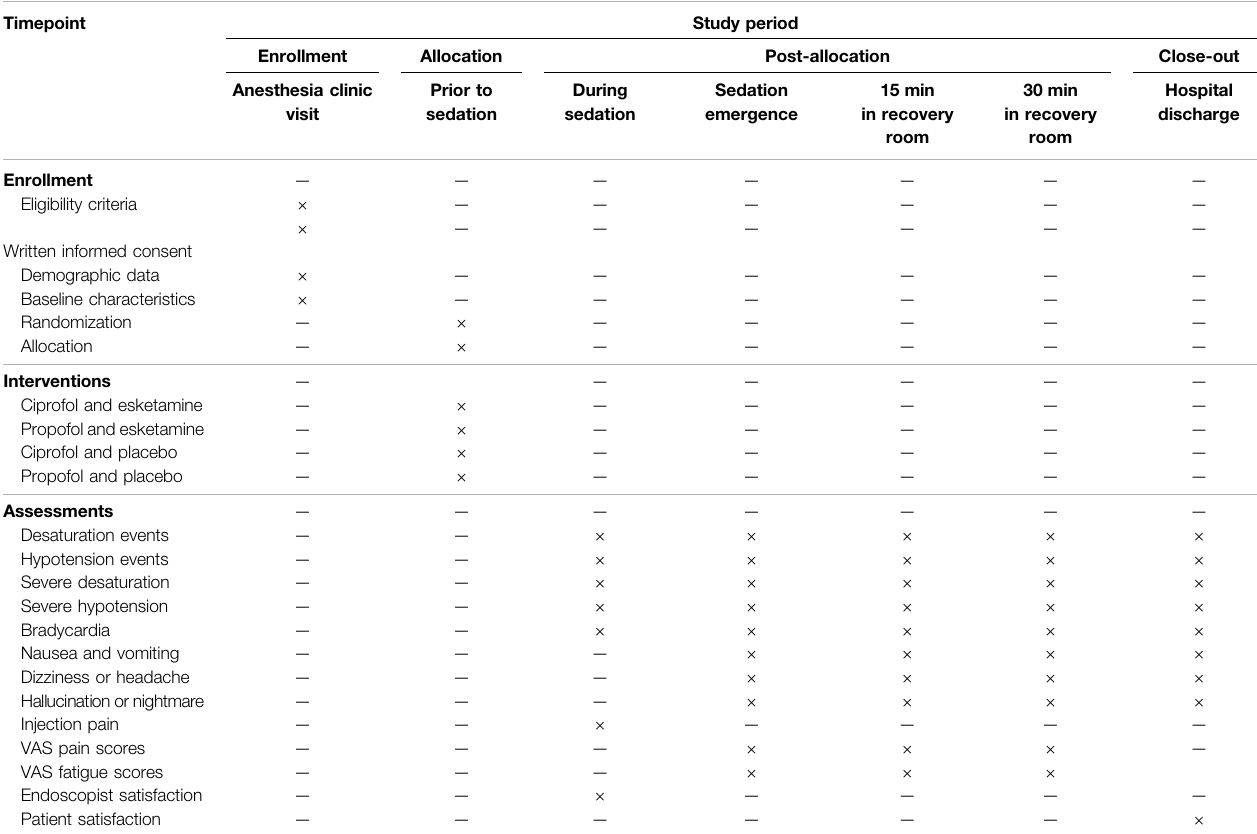
TABLE 1 | Schedule of enrollment, interventions, and